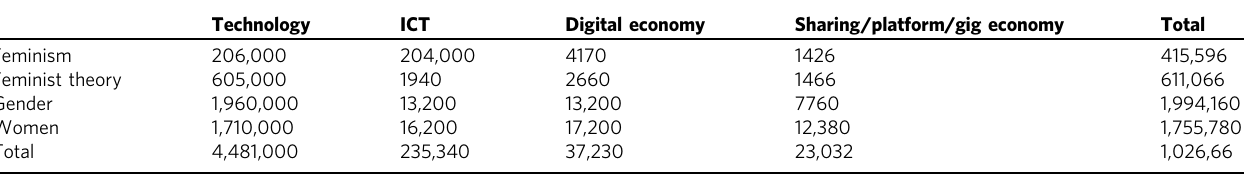
Table 4 Results from the search on Google Scholar 1995 – June 2020 for each search